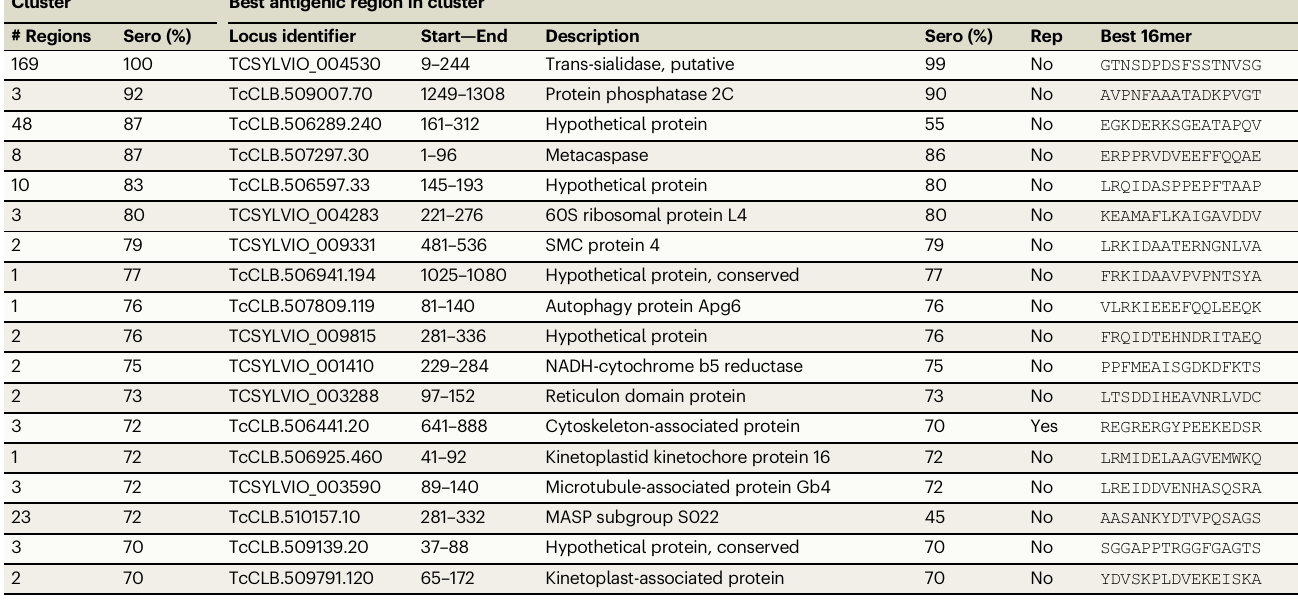
Alistofthe18clustersofantigenicregions,whichshowedreactivityagainstatleast70%ofthepositiveindividualserumsamples,didnotshowcross-reactivityagainstleishmaniasis-positiveserum samplesinthepreviousassay,andforwhichatleast90%ofitsregionswerenotsimilartoalreadyknownantigenicepitopesfoundintheIEDB.Foreachcluster,weshowarepresentativeantigenic region with the highest seroprevalence in CHAGASTOPE-v2. All 3868 antigenic clusters can befound inSupplementary DataS7. # Regions number ofregions in saidcluster, Sero seroprevalence, Rep repetitive (containsinternal tandem